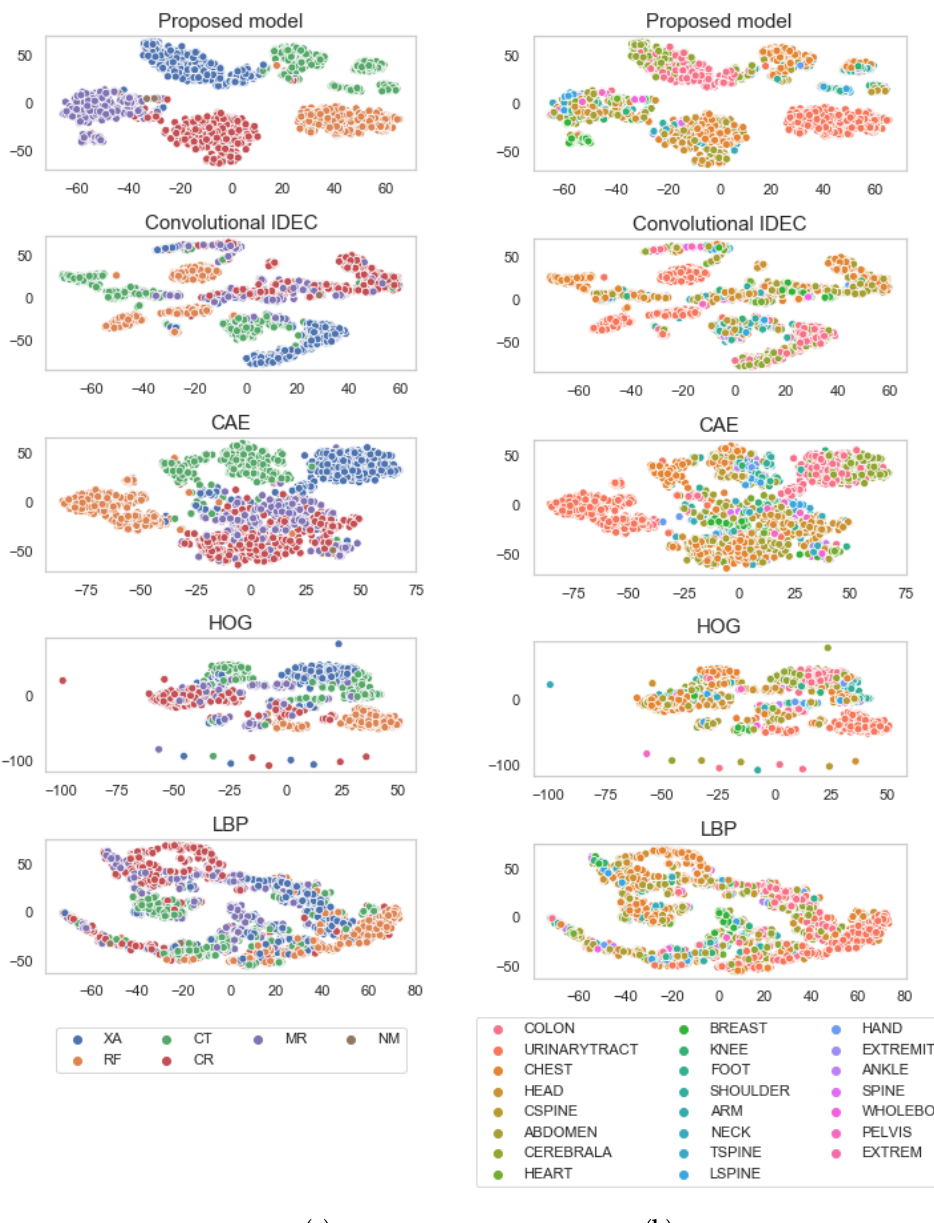
Figure 5. t-SNE visualisation of the embedding space. Each row depicts the embedding space of one of the modelling approaches used in the experiments, with respect to the: ( a ) Mod tag, and ( b ) AR